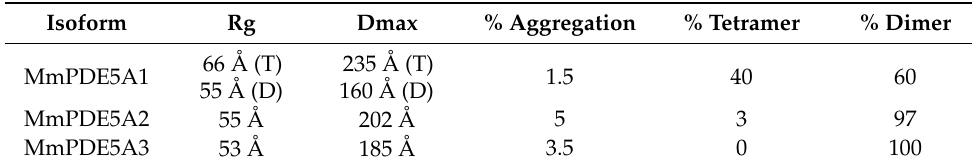
Table 2. Summary of SAXS data analysis. The fraction of aggregated proteins, dimeric and tetrameric forms, were derived through gaussian deconvolution of the scattered curves dI(q)/dt with the US-SOMO HPLC-SAXS module [23]. Then, the corresponding I(q) vs. q curves of each deconvoluted peak were analyzed individually to retrieve the Rg and Dmax values.